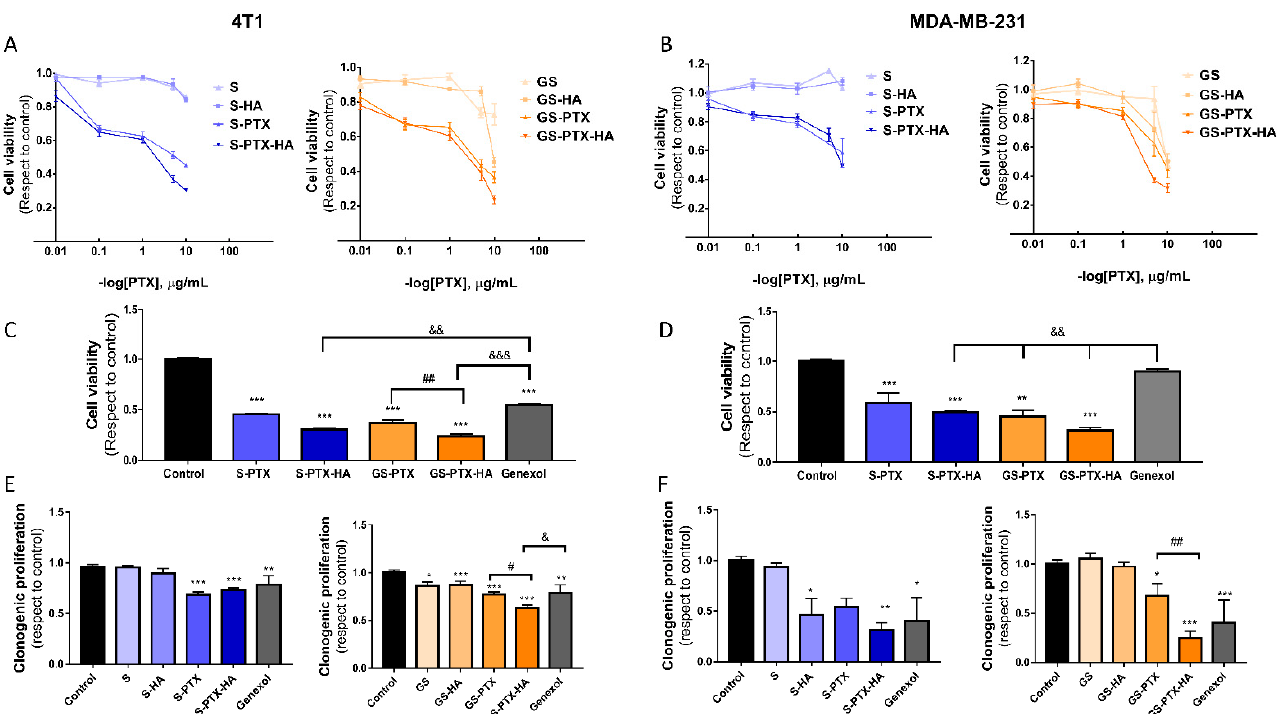
Figure 2. Cytotoxic effect of the micellar formulations. ( A – D ) Cell viability was evaluated by Celltiter-Blue assay after 72 h of treatment. ( C , D ) Cell viability at 10 µg/mL PTX and Genexol ® is shown. ( E , F ) n = 3–5 independent experiments performed in quintuplicate for each condition and cell line. Clonogenic proliferation was assessed in untreated (control) or treated cells with Soluplus ® micellar systems (PTX and Genexol ® 0.001 µg/mL) for 7 days. Error bars represent the mean ± SEM ( n = 3 independent experiments performed in triplicate for each condition and cell line) (ANOVA and Tukey’s multiple comparisons test, * p < 0.05, ** p < 0.01, *** p < 0.001 vs. control; # p < 0.05, ## p <